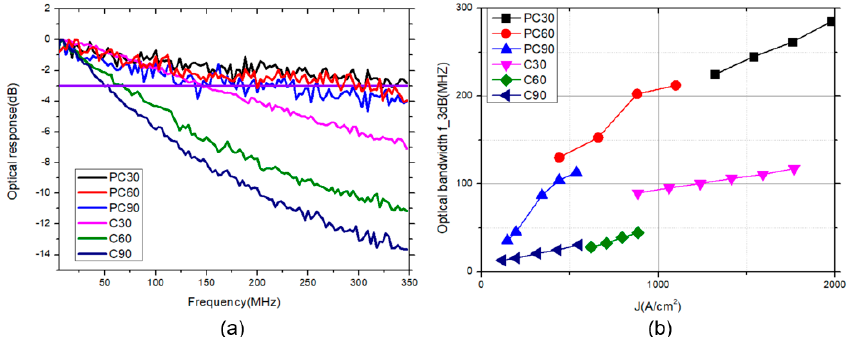
Figure 7. ( a ) Frequency responses of PC-FCLEDs and FCLEDs at an injection current of 50 mA, 100 mA, and 150 mA with mesa radii of 30 µm, 60 µm, and 90 µm, respectively. ( b ) Optical bandwidth f − 3dB of PC-FCLEDs and FCLEDs at various current densities.